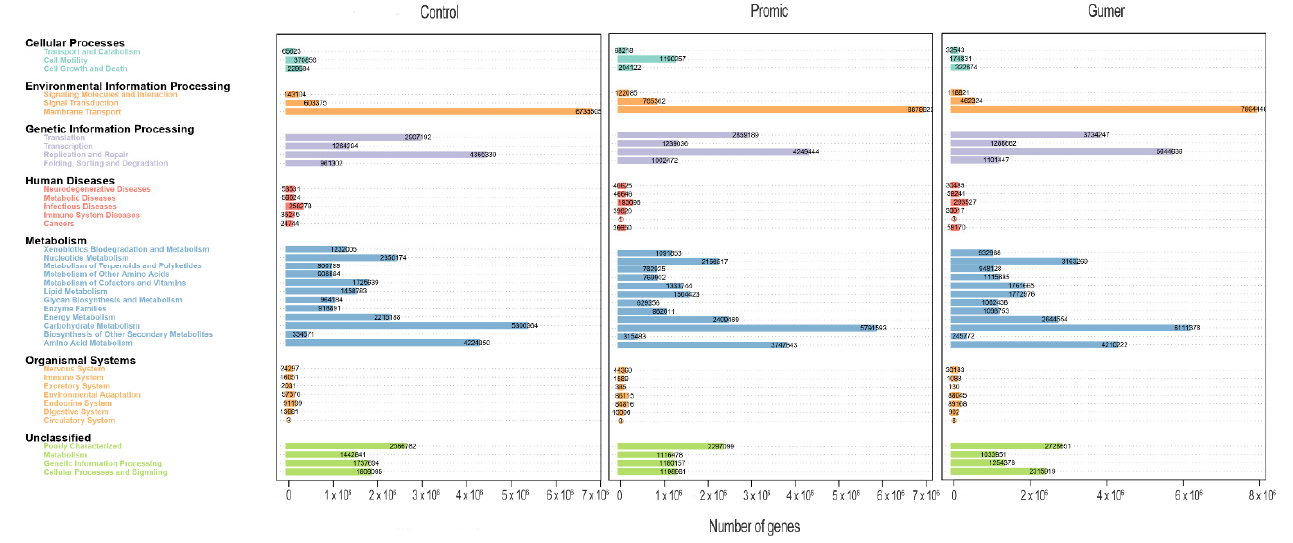
Figure 8. The statistics of the relative abundances of metabolic pathways within KEGG categories.